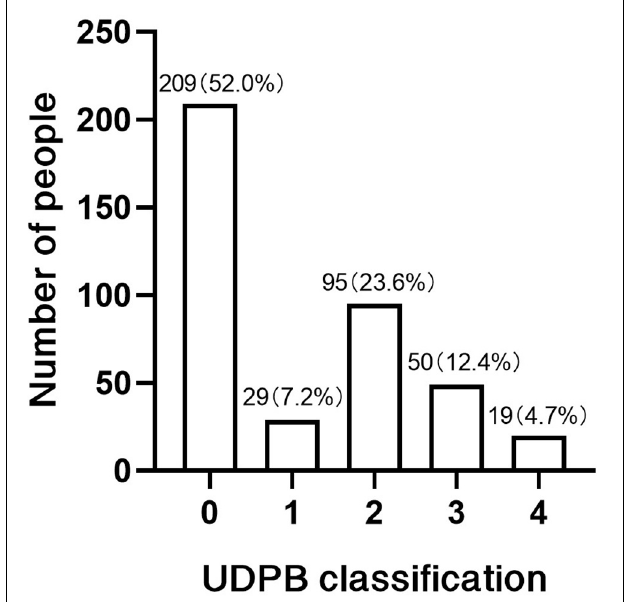
FIGURE 1 | Bleeding classification according to the